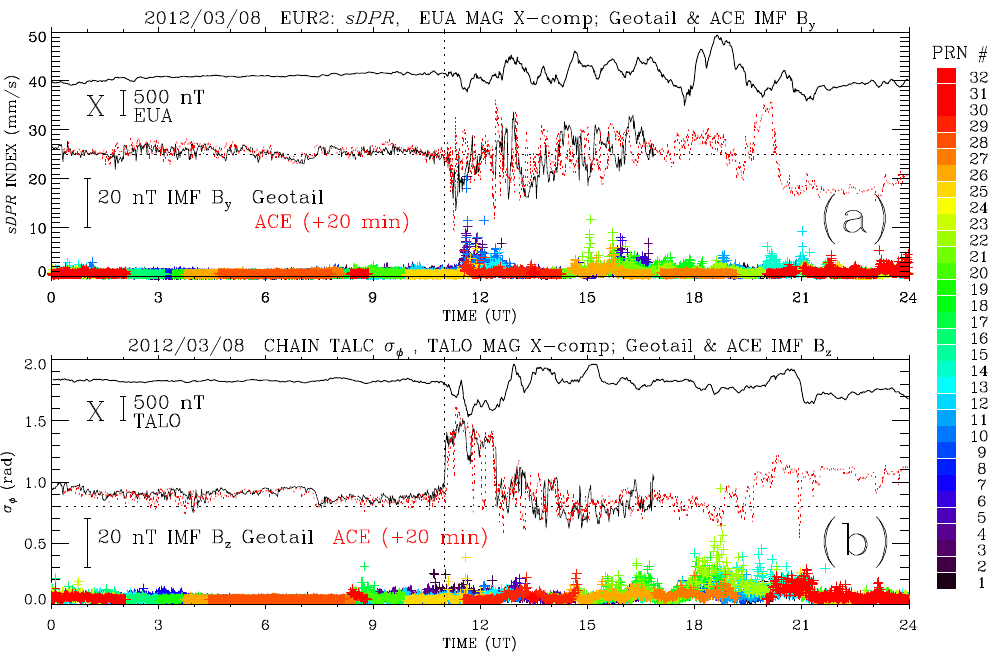
Figure 8. (a) The phase scintillation proxy index sDPR (colored crosses) for elevations above 30 ◦ , and the X component of the ground magnetic field at Eureka. (b) The phase scintillation σ (cid:56) , the X component of the ground magnetic field observed in Taloyoak, and the IMF B z . The dotted vertical line indicates the interplanetary shock arrival time at Geotail. Superposed in (a) and (b) is the IMF B y in geocentric solar ecliptic (GSE) coordinates observed by Geotail before it entered the post-noon magnetosheath and ACE in the upstream solar wind (dotted red line; shifted by